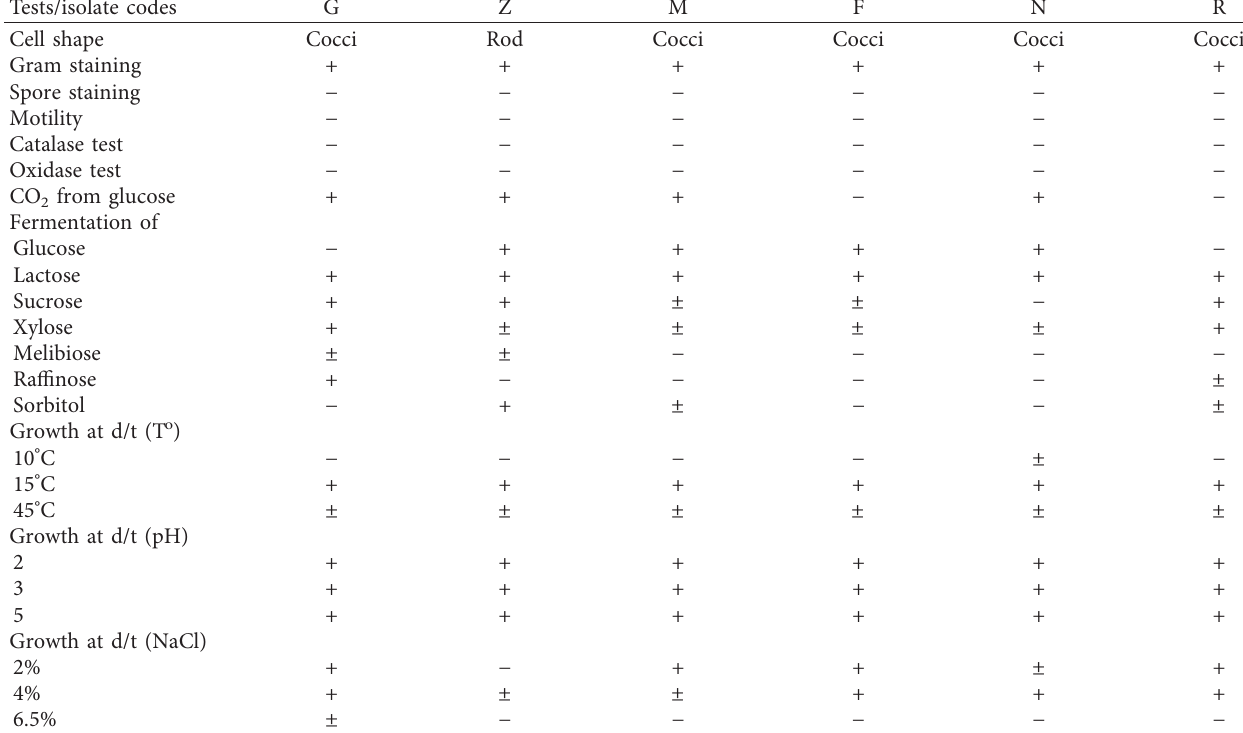
Table 1: Morphological, physiological, and biochemical characteristics of the isolated LAB from fermented Ethiopian dairy products of Pawe Woreda.